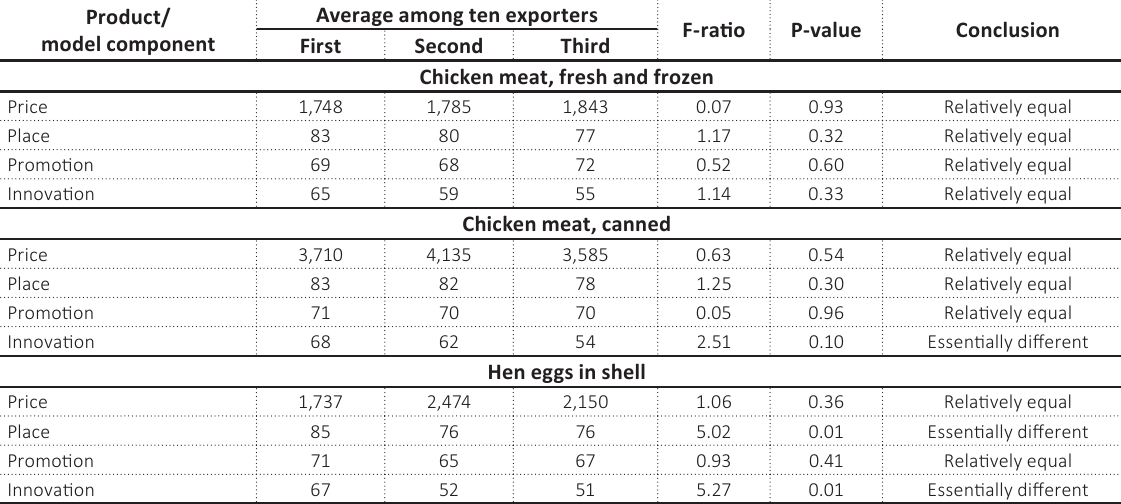
Source: Computed by the authors.